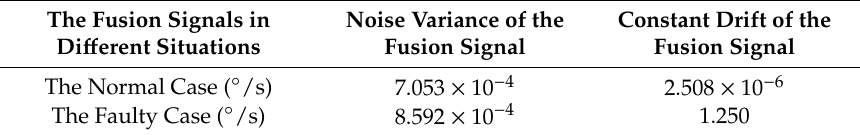
Figure 1. The simulation experiment in the two situations: ( a ) The gyro measurement signals in normal and faulty situations; ( b ) the fused signals of the X-axis in normal and faulty situations; ( c ) the weight coefficient of the faulty gyro. Table 1. The detailed information of the fused signals.